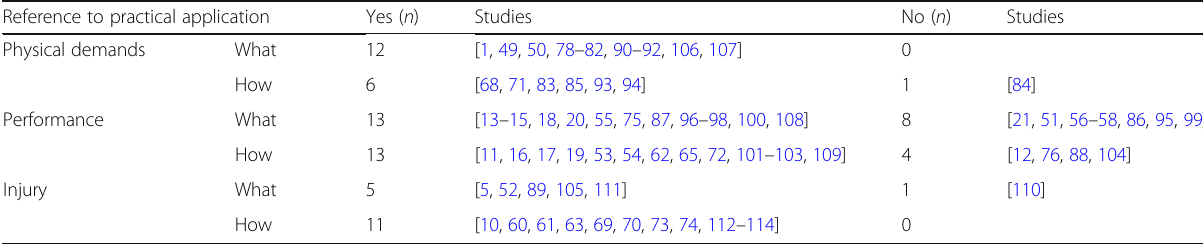
Table 7 A summary of the reference to practical application Reference to practical